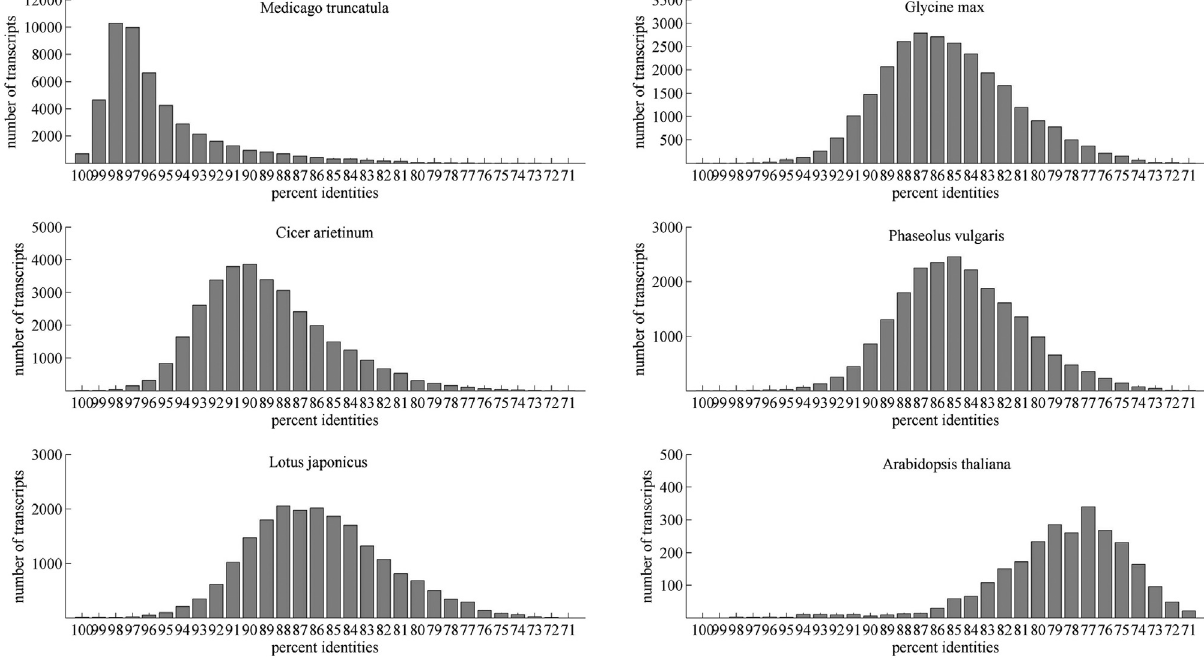
Figure 2 - Sequence identity distribution of alfalfa unique transcripts to other